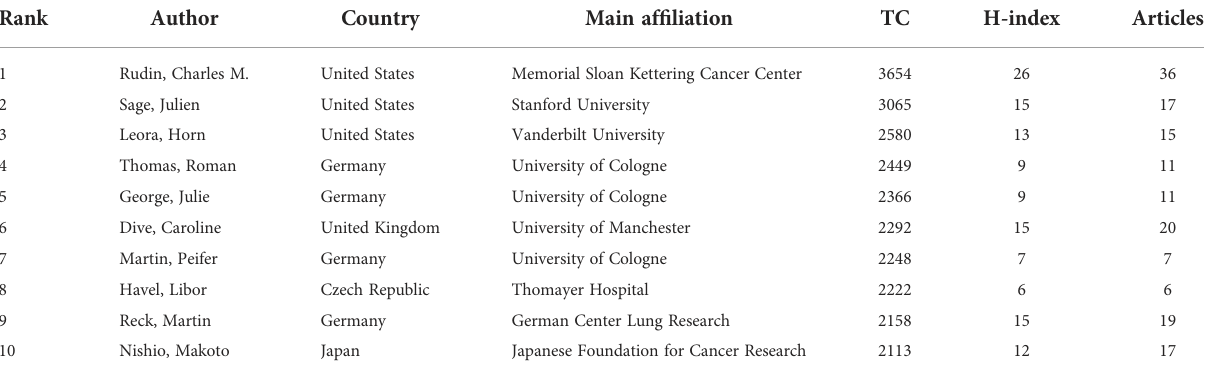
TABLE 4 The top 10 high-yield authors measured by